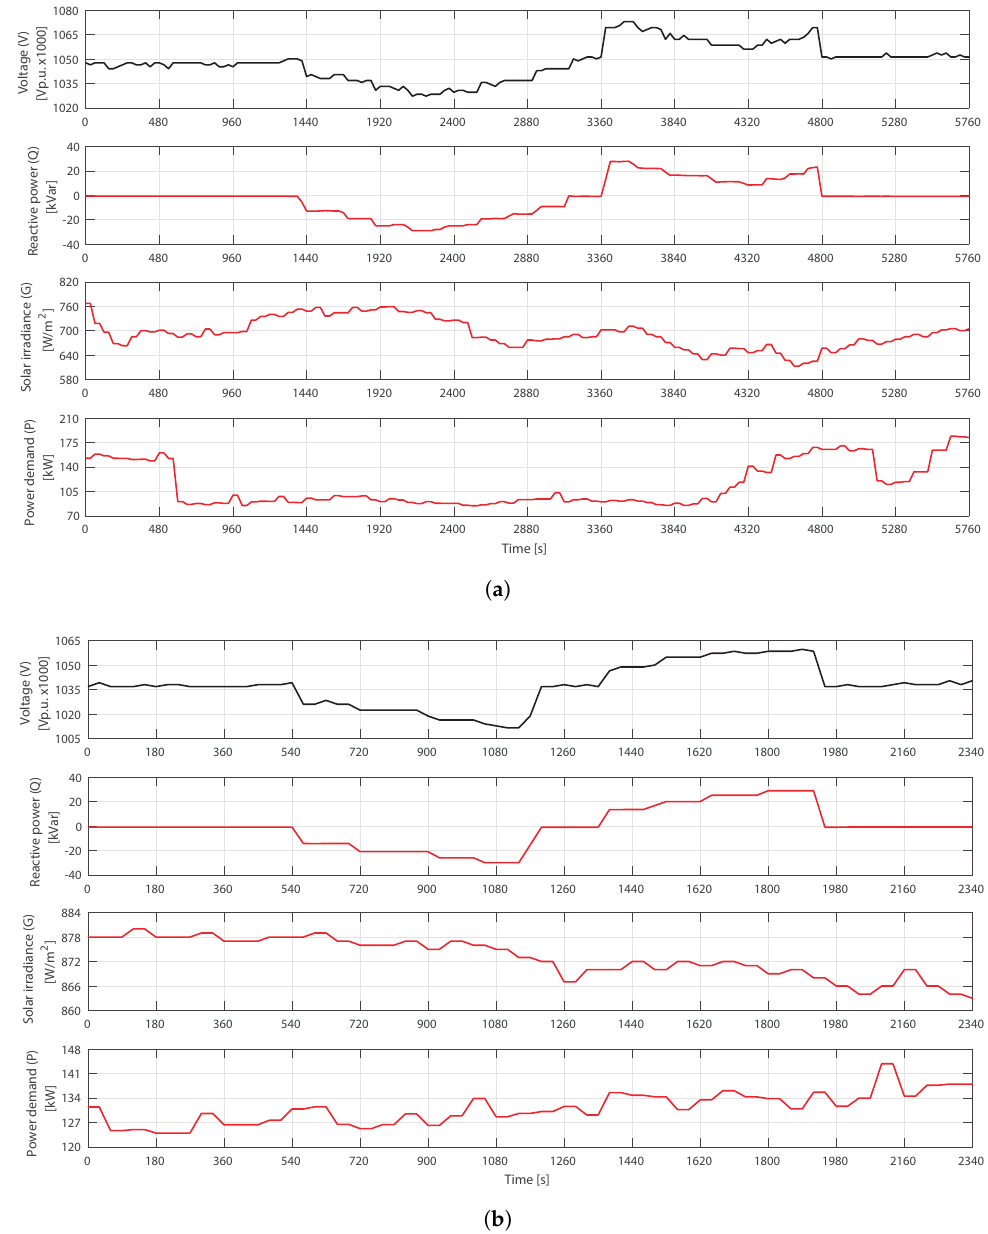
Figure 4. Physical microgrid results for reactive power variation tests on B11_ADM PV system. Red-colored lines are inputs and black-colored lines are outputs. ( a ) Model identification experimen- tal dataset; ( b ) Model validation experimental